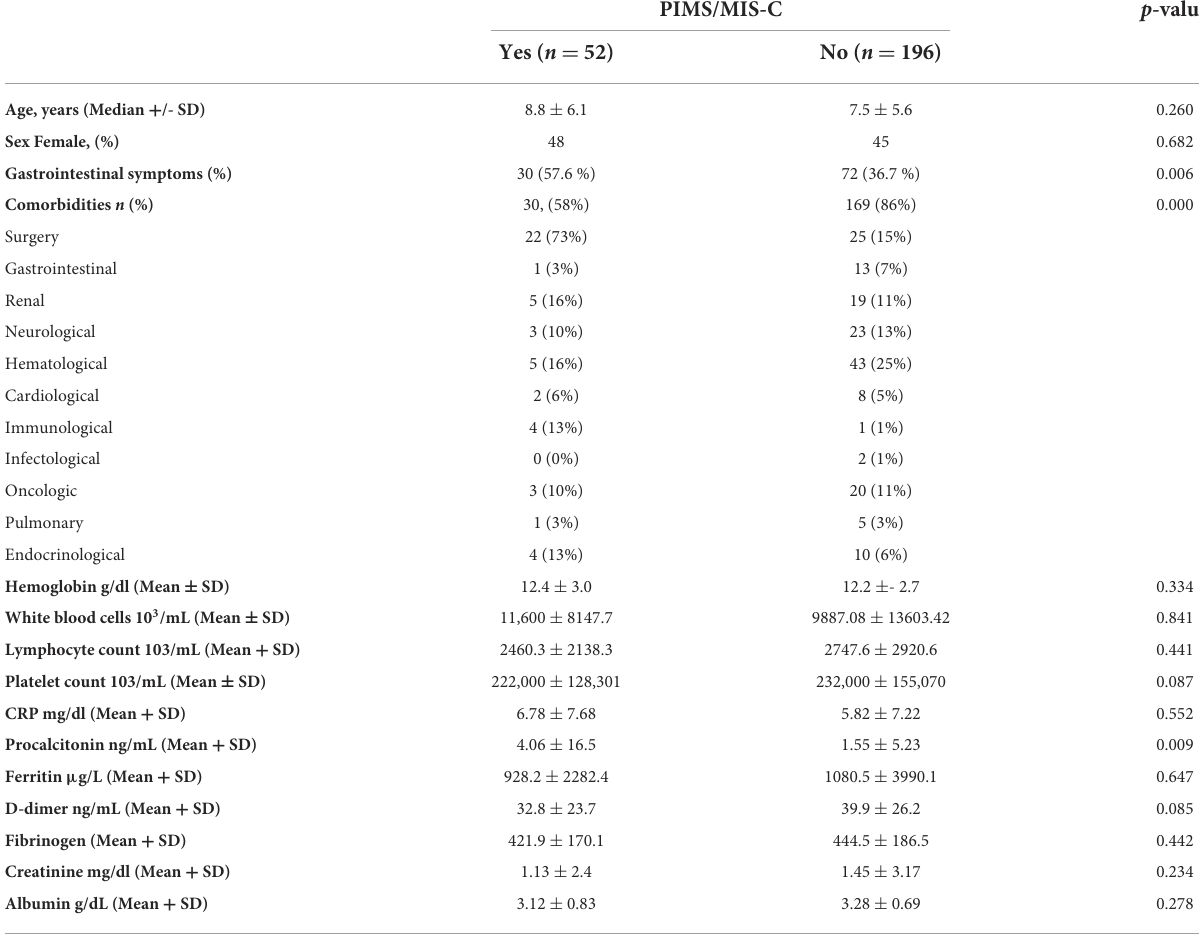
TABLE 1 Demographics, gastrointestinal presenting symptoms and associated comorbidities, and laboratory